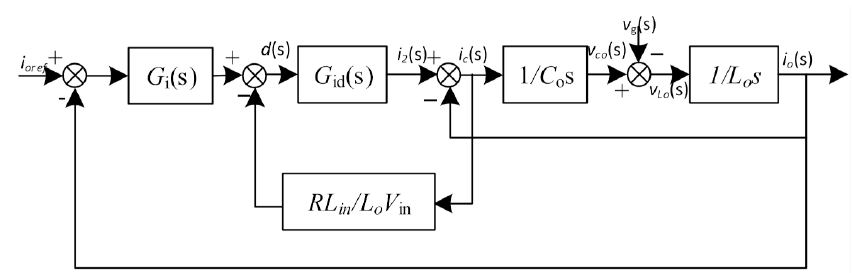
Figure 14. Equivalent control diagram with output capacitor current